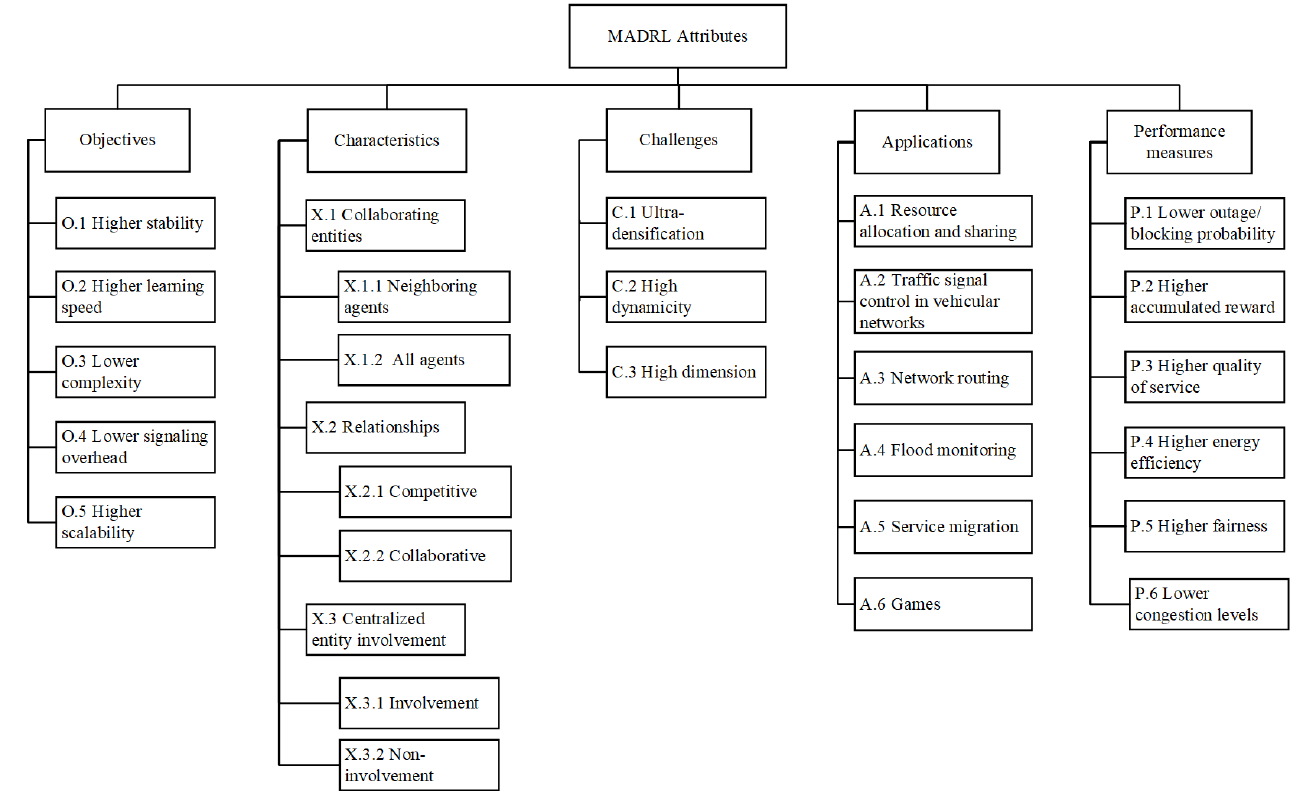
Figure 3. Taxonomy of MADRL